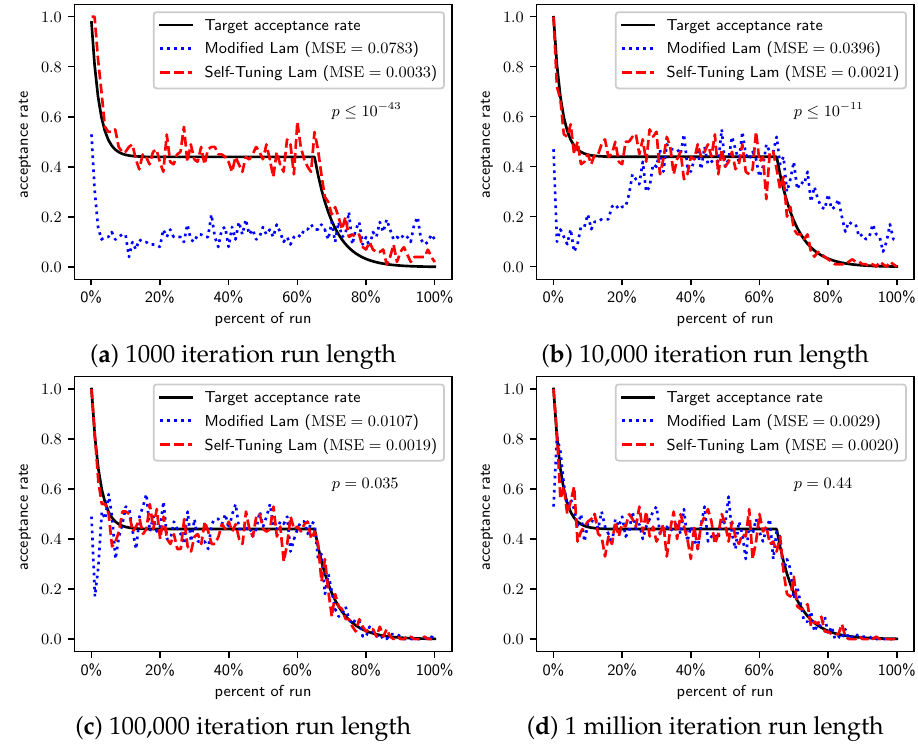
Figure 14. Minimize f 2,100 ( x ) : Self-Tuning Lam, Modified Lam, and target acceptance rates